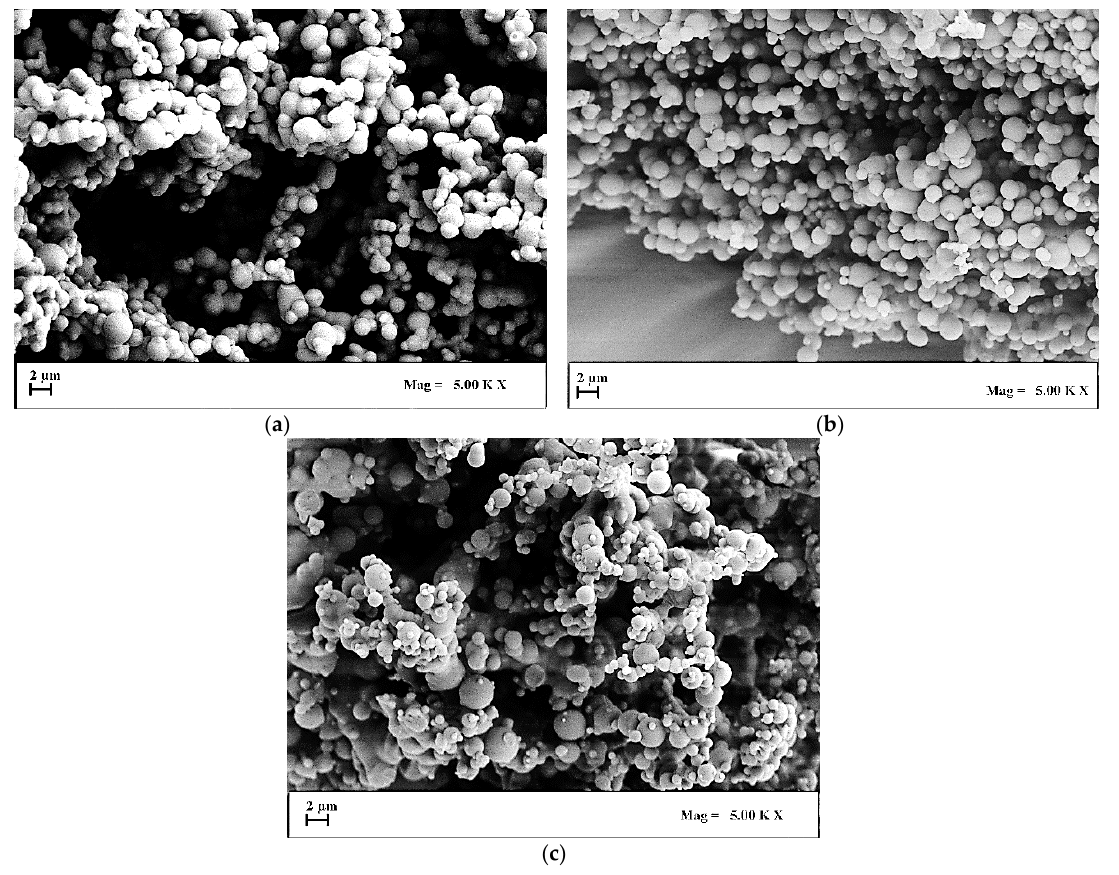
Figure 2. FESEM images of Eudragit particles precipitated from DMSO at 40 °C and 20 mg/mL. Effect of the operating pressure. ( a ) 9 MPa; ( b ) 10 MPa; ( c ) 12 MPa.3.1.2 Effect of polymer concentration in DMSO.